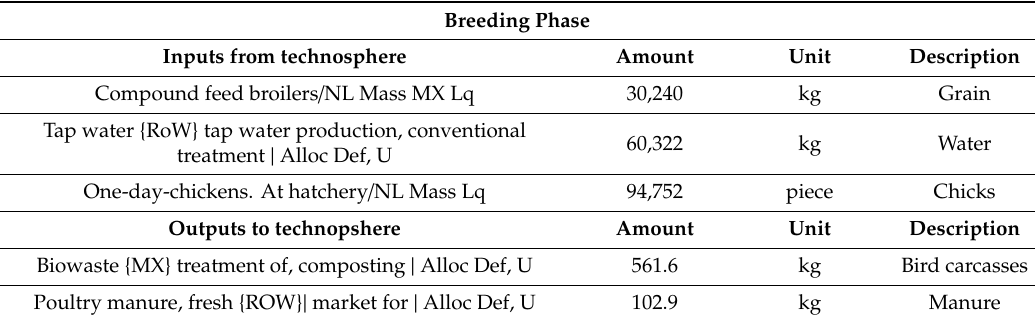
Table 3. Material inventory database from poultry farm per production